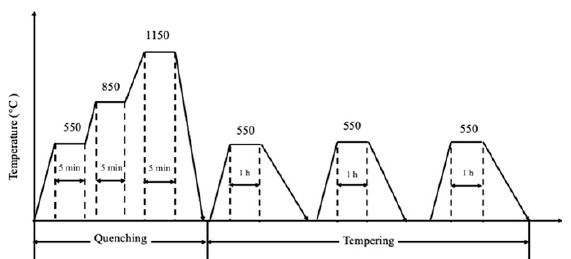
Figure 2. The schematic diagram of heat treatment of the S390 MMCs.